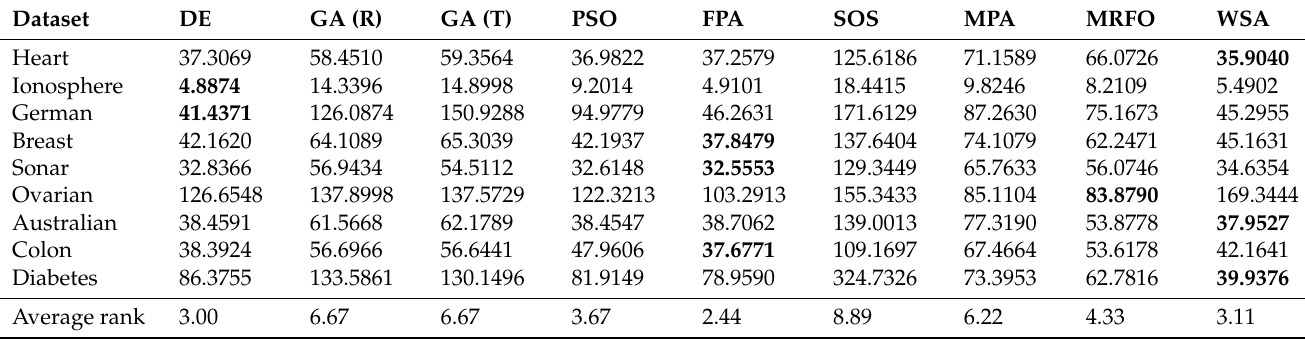
Table 7. Best computational time achieved by each algorithm for each